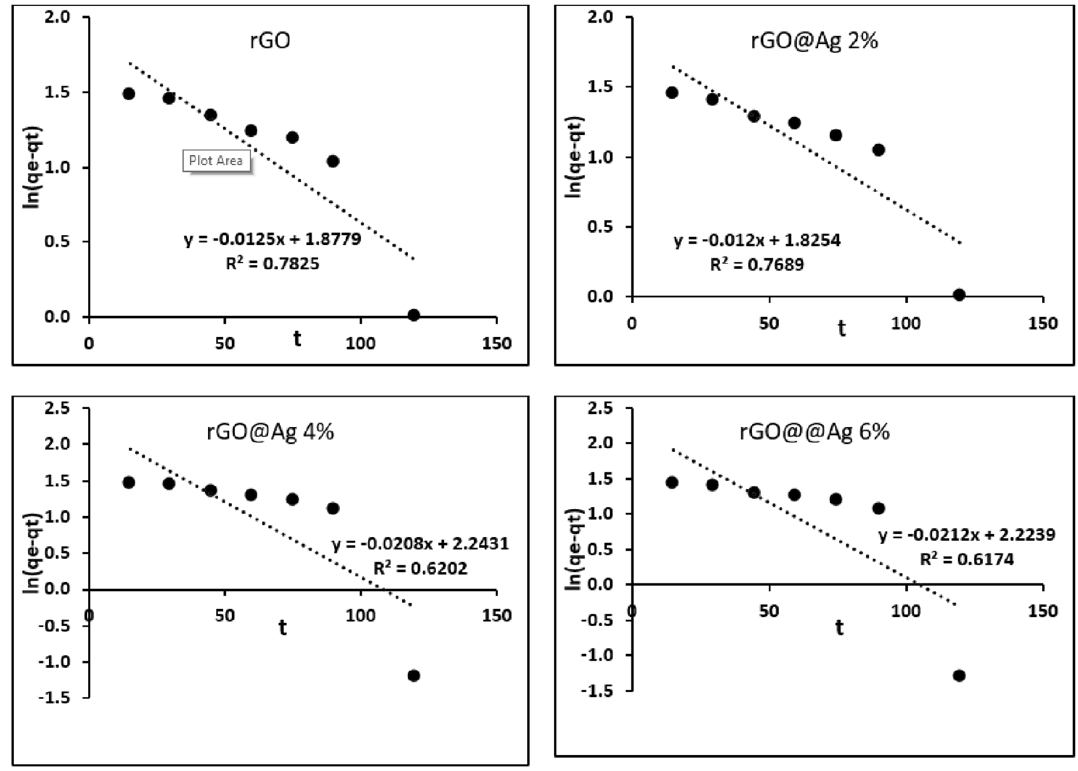
Fig. 14 Graph of the pseudo-first-order reaction for CR dye degradation using as-synthesized rGO and rGO@Ag x